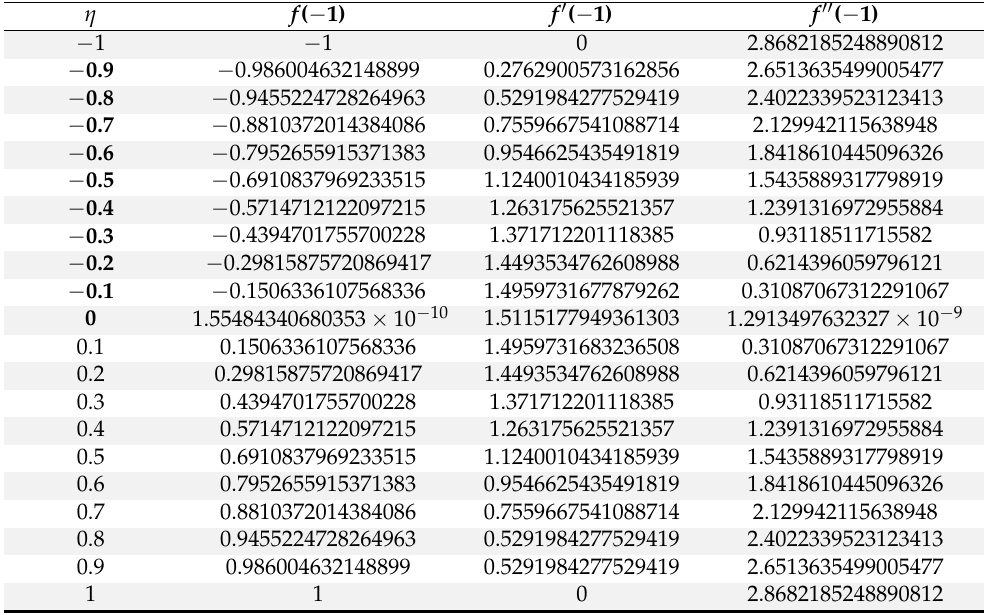
Table 8. Numerical stability of outcomes at various values of η